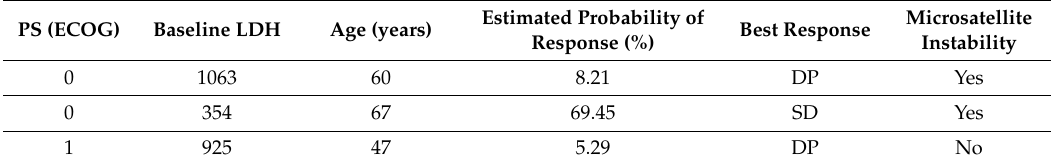
Estimated probability of response in colorectal patients according to microsatellite mutational